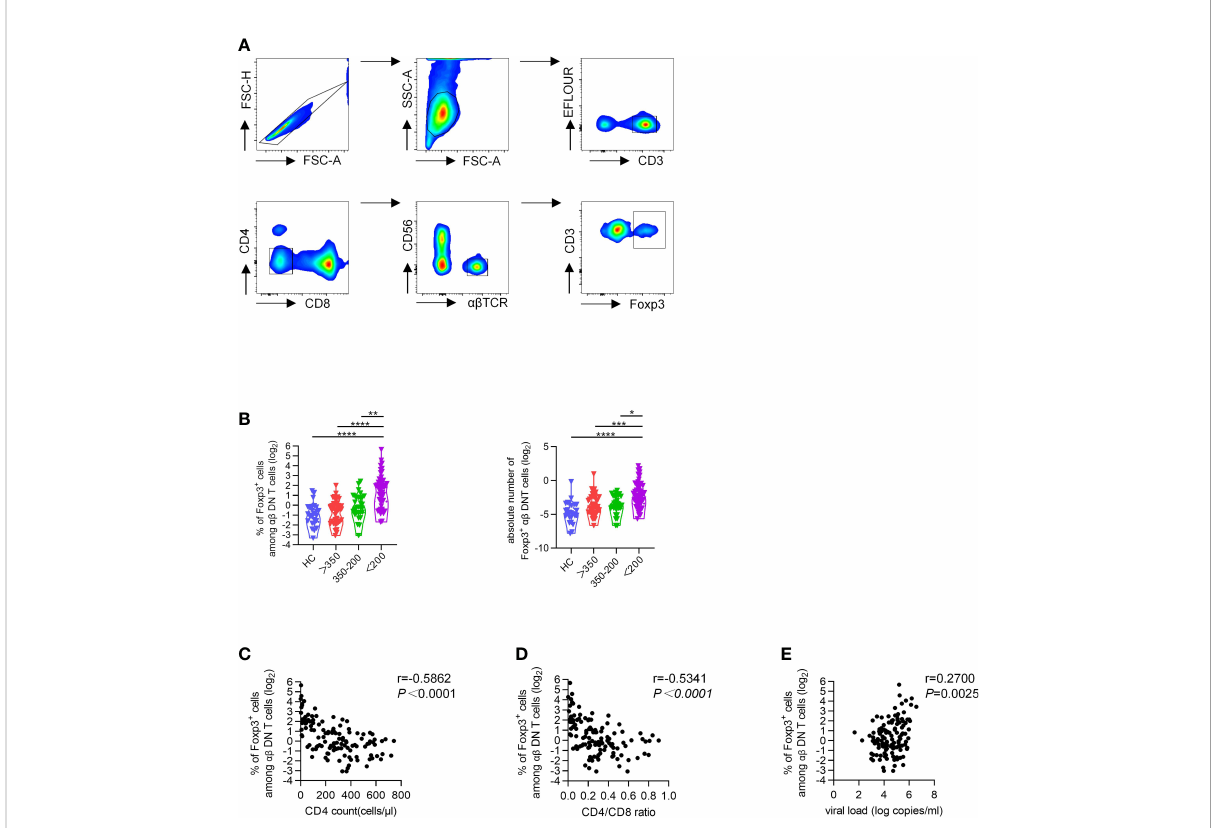
FIGURE 1 Increased proportions of Foxp3 + DNT cells associated with progressive HIV disease. Flow cytometry analysis of Foxp3 expression was performed on PBMCs collected from HCs and different TNs groups. (A) Representative fl ow data showed the expression of Foxp3 on DNT cells from TNs. (B) Violin plots of the percentage of Foxp3 + DNT cells from HCs and different TNs groups (n=20-66 each group). P values were obtained by Kruskal-Wallis test followed by Dunn ’ s multiple comparisons test. (C – E) Correlation analysis of the percentages of Foxp3 + DNT cells with CD4 + T cell count (C) , CD4/CD8 ratio (D) , HIV viral load (E) in PHIV infected patients without treatment. The percentage of Foxp3 + DNT cells was represented on a log2 scale. The correlation was calculated using Spearman ’ s non-parametric test. * P < 0.05, ** P < 0.01, *** P < 0.001, **** P <